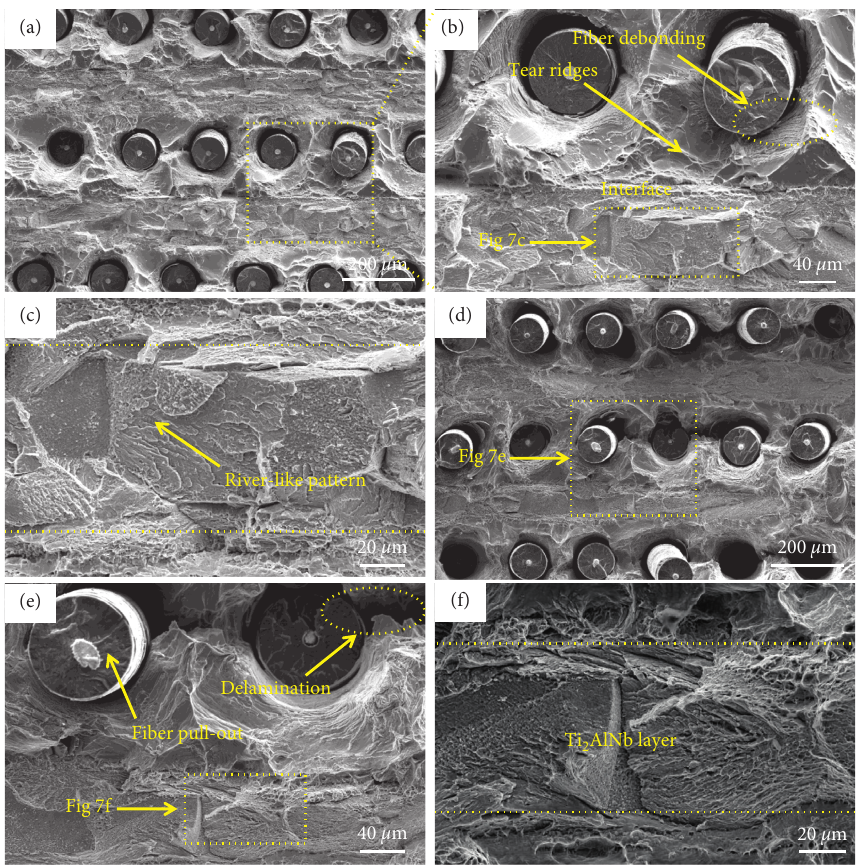
Figure 7: Tensile fracture of the composite: (a–c) at room temperature and (d–f) at high